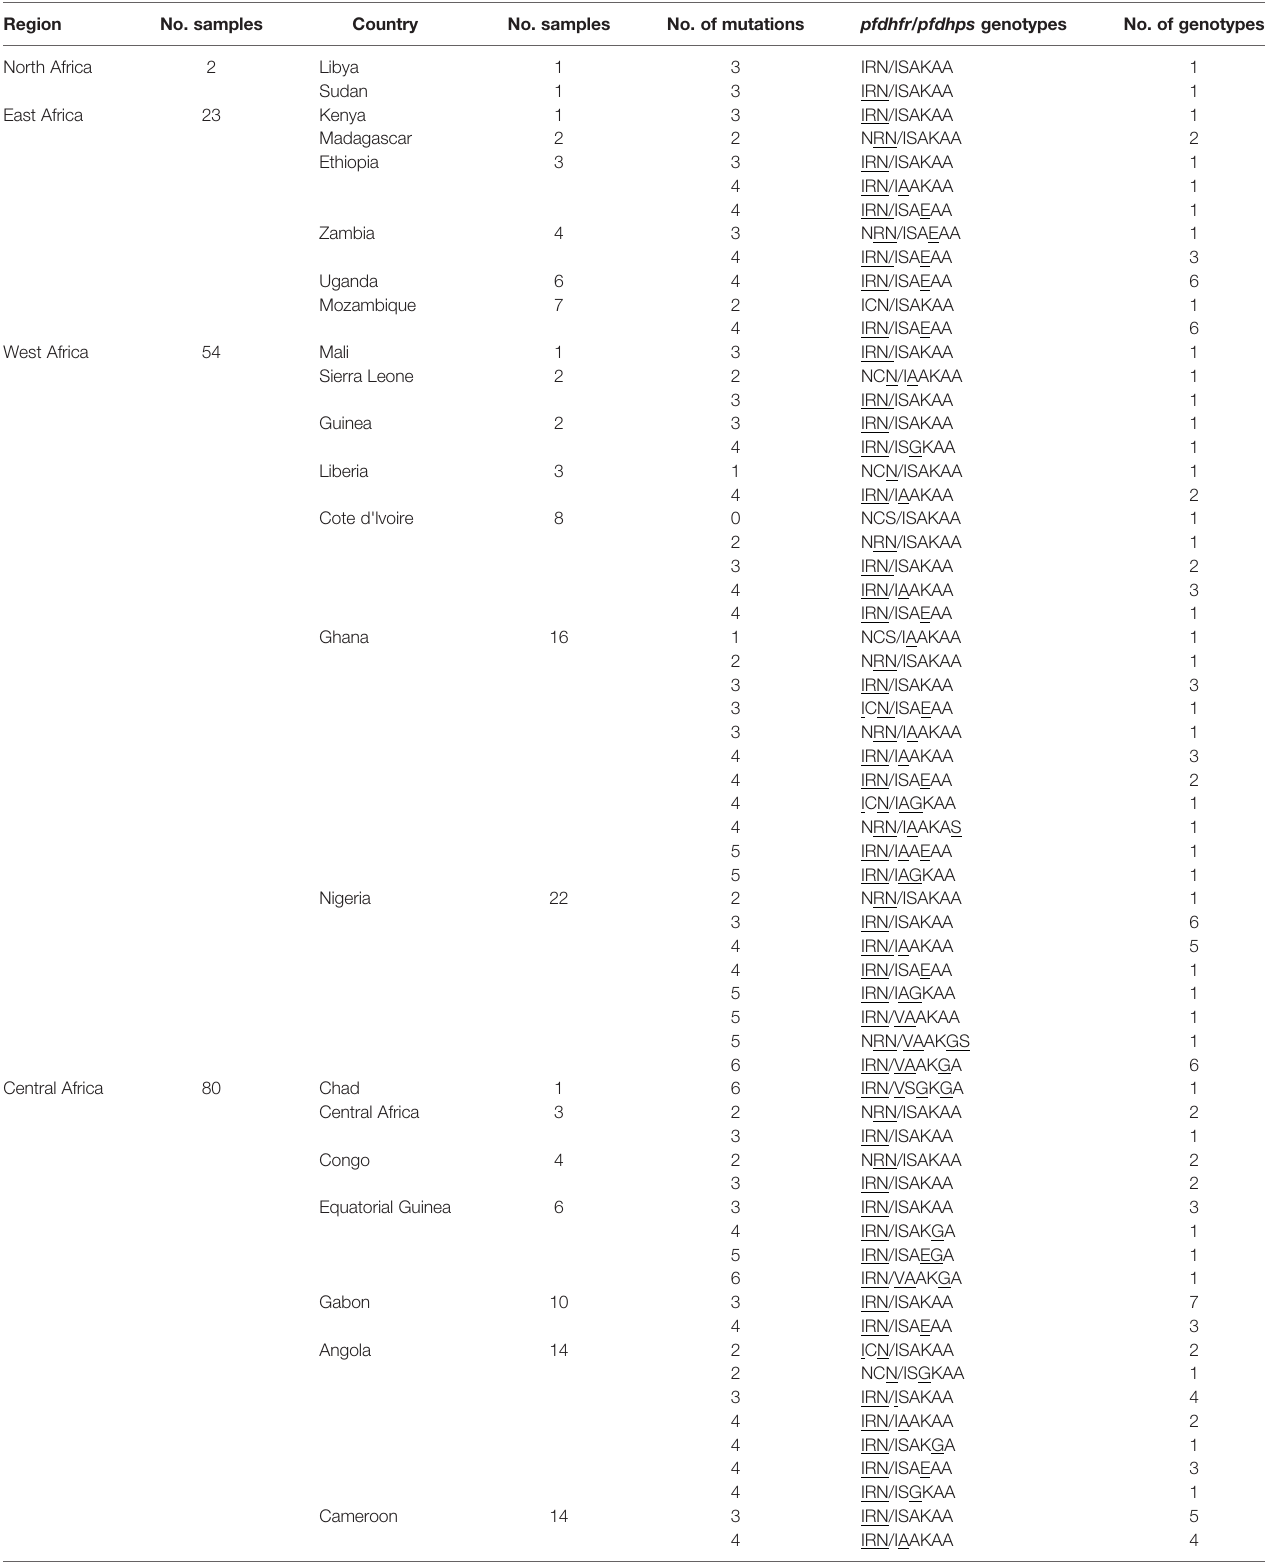
TABLE 3 | Geographical genetic analysis of pfdhfr/pfdhps genotypes. Region No. samples Country No. samples No. of